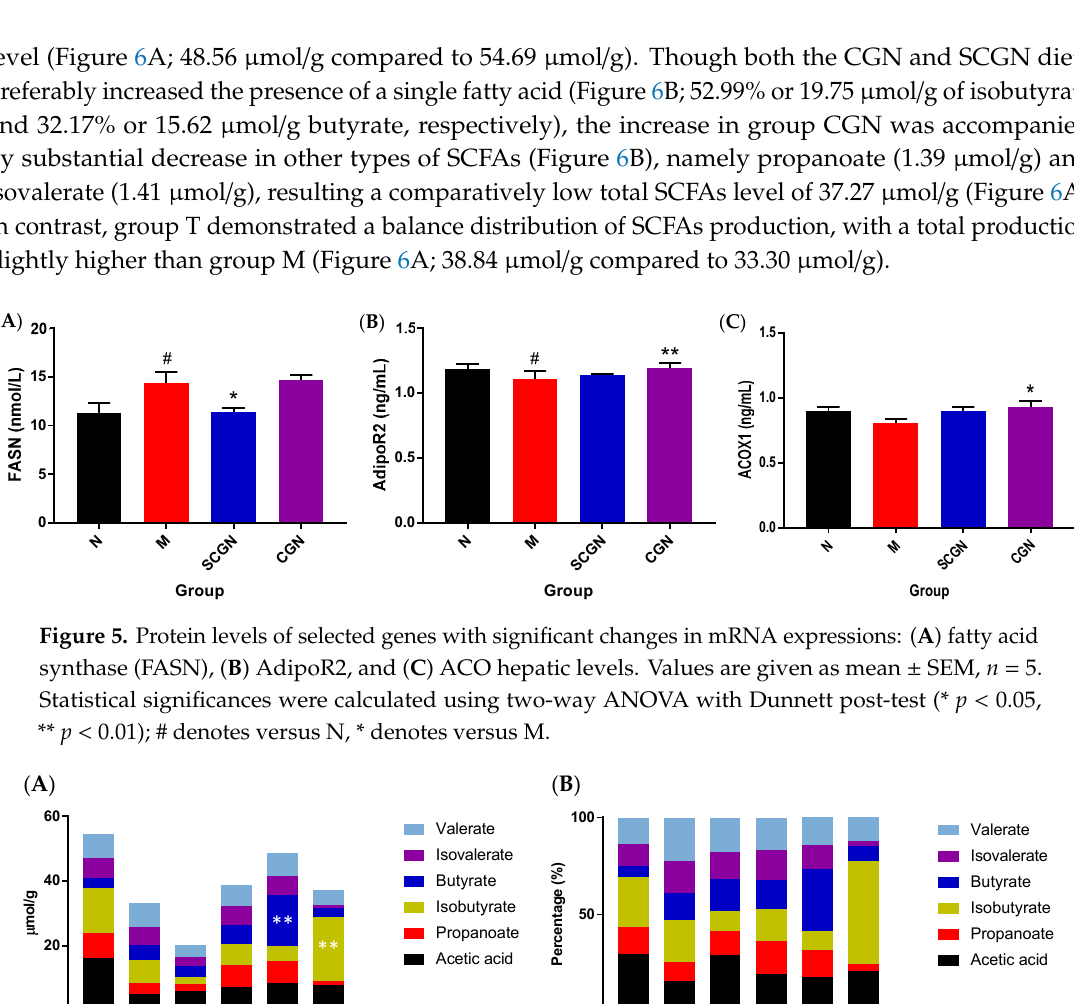
Figure 6. Measurements of total fecal short-chain fatty acids ( A ) and proportion of individual fatty acids ( B ) in mice and the isobutyrate level of CGN compared to M. N = Normal, M = Model, T = Whole Kappaphycus , SCGN = Sans-carrageenan fraction, CGN = Carrageenan; Statistical significances were calculated using two-way ANOVA with Dunnett post-test (** p < 0.01), n = 8.